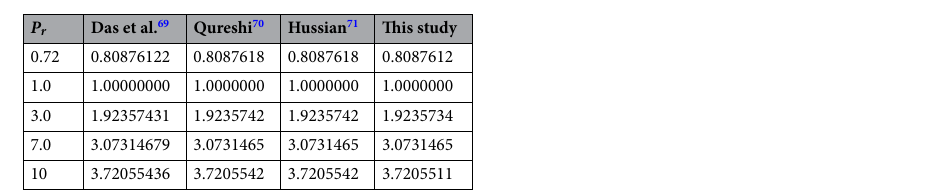
′ ( 0 ) Table 1. Comparing − θ with alteration in Prandtl number, and taking δ 1 = Rd = Nt = γ 1 = γ 2 = γ 3 = 0 and Nb = 0